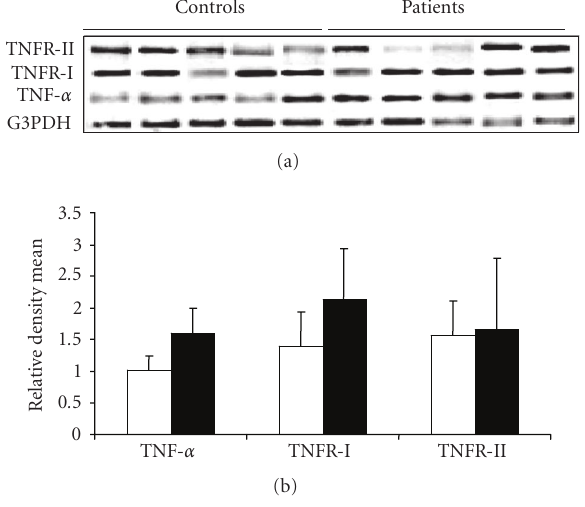
Figure 2: (a) Agarose gel (1.2%) showing gene expression profile of TNF- α , TNFR-I, and TNFR-II from PBMCs of five representative healthy controls and RA patients. G3PDH gene was used for esti- mating the relative density of gene specific expression. (b) Relative density mean (density of gene specific product/density of house- keeping gene G3PDH) of 30 healthy controls and 27 RA patients for the expression of the genes.